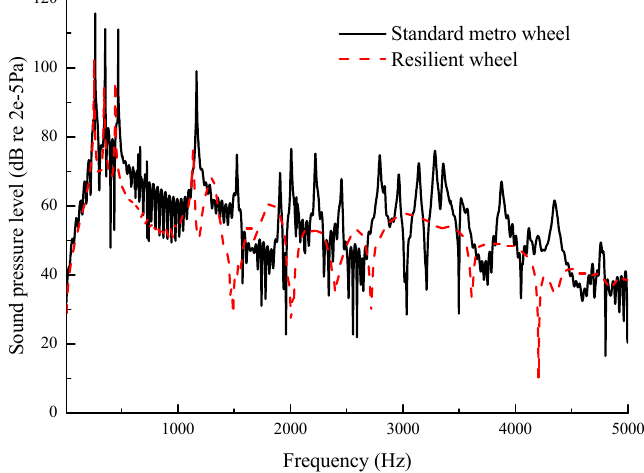
Figure 18. SPL compare between standard metro wheel and elastic wheel (simulation results).